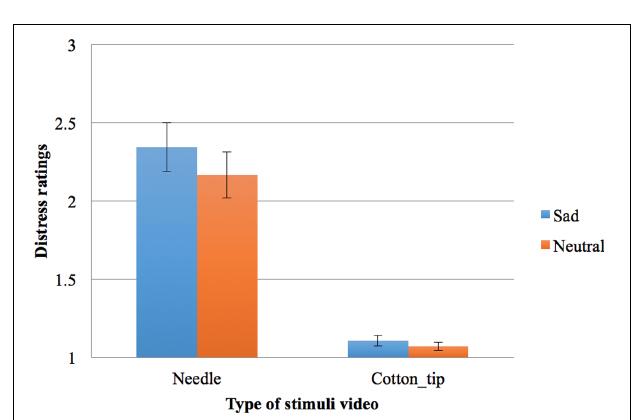
FIGURE 4 | Participant sample two’s distress ratings on a scale from 1 to 5 (1 = not distressing at all, 5 = very distressing) for two types of stimuli (painful needles or non-painful cotton-tips) in the two mood conditions (bars shown are standard